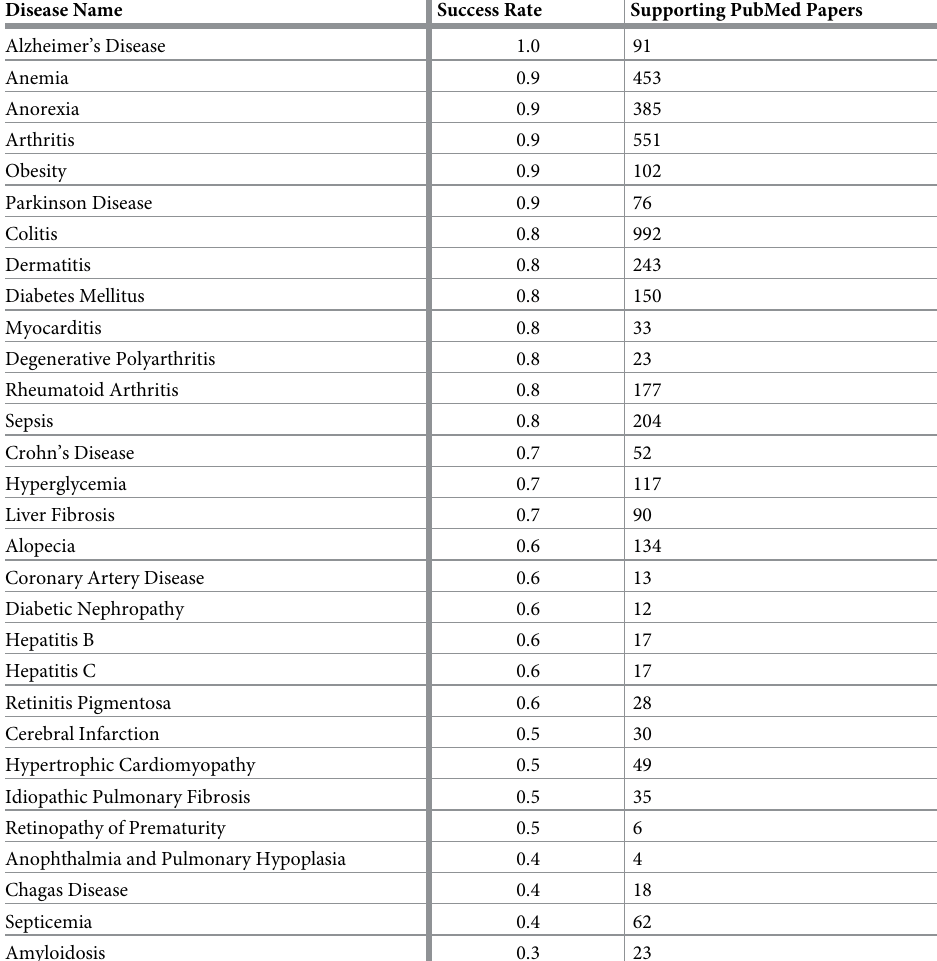
Table 3. A summary of literature evidence for the Top 10 predicted genes that are not associating with a disease for each of the selected 30 diseases. The Success Rate column is the ratio between the number of predicted genes with PubMed supporting evidence divided by